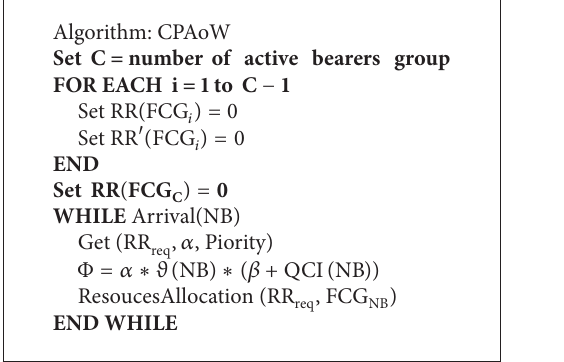
Algorithm 1: CPAwO algorithm.